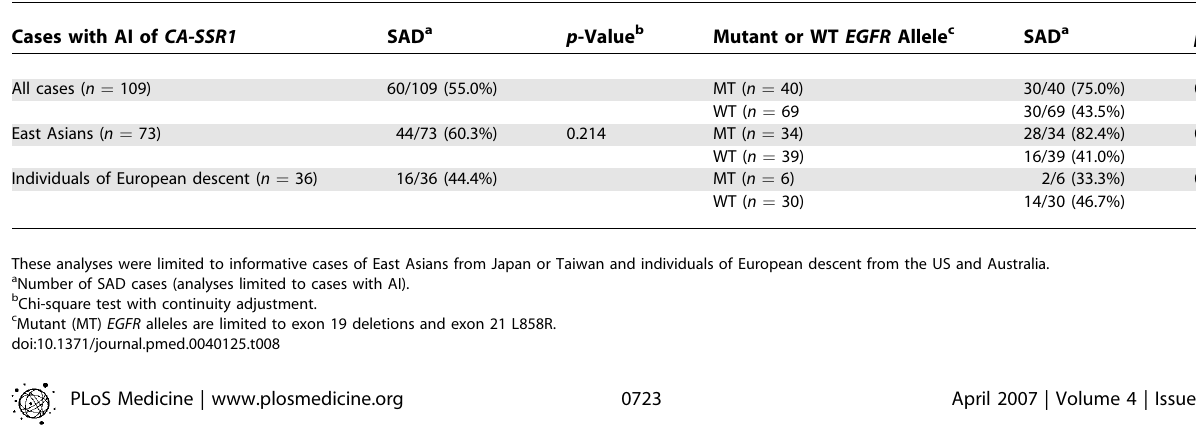
Table 8. Frequencies of AI of CA-SSR1 by